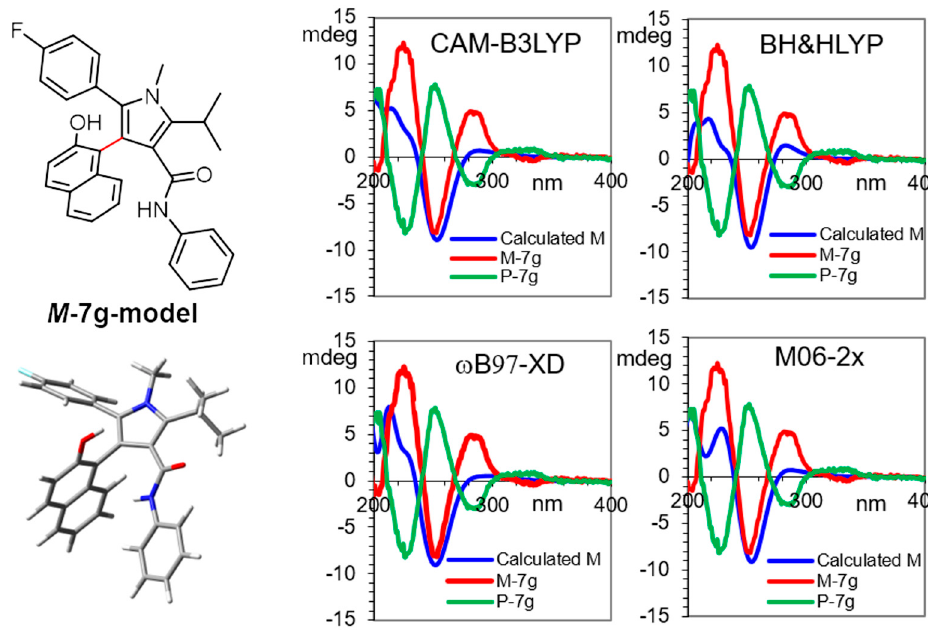
Figure 3. M -7g and P -7g atropostatin–lactones experimental ECD spectra, recorded in ACN (red and green lines). Their comparison with the calculated spectra of M- 7g model is shown (blue lines). Four different functionals and 6-311++G(2d,p) basis set were used. To obtain a better overlap, the calculated spectra were red-shifted by 10 nm for CAM-B3LYP and M06-2X, 14 nm for BH&HLYP and 12 nm for ω B97-XD, while they were multiplied by a factor of 0.23 for CAM-B3LYP, 0.25 for BH&HLYP, 0.24 for ω B97-XD and 0.18 for M06-2X.